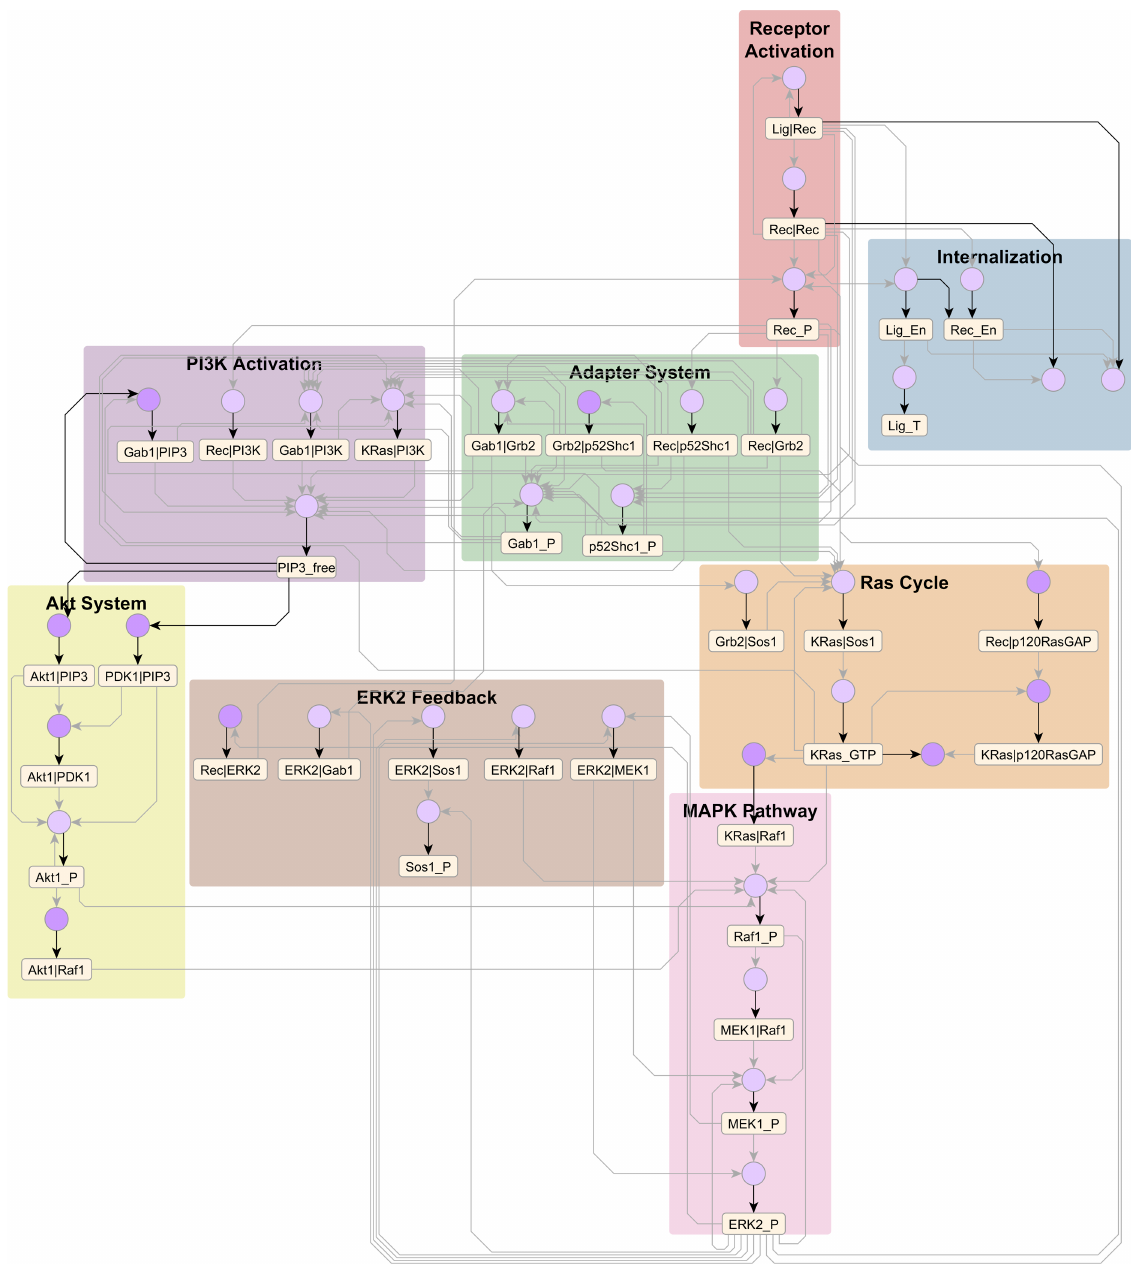
Fig 8. ErbB library of rules. Compressed AR graph (79 nodes, 144 edges) generated from the ErbB model of Creamer et al. [14]) with 625 rules. The uncompressed graph has 930 nodes and 5269 edges. The model elementscan be roughly classifiedinto eight subsystems shown above. The files neededto reproducethis diagramare providedin S1